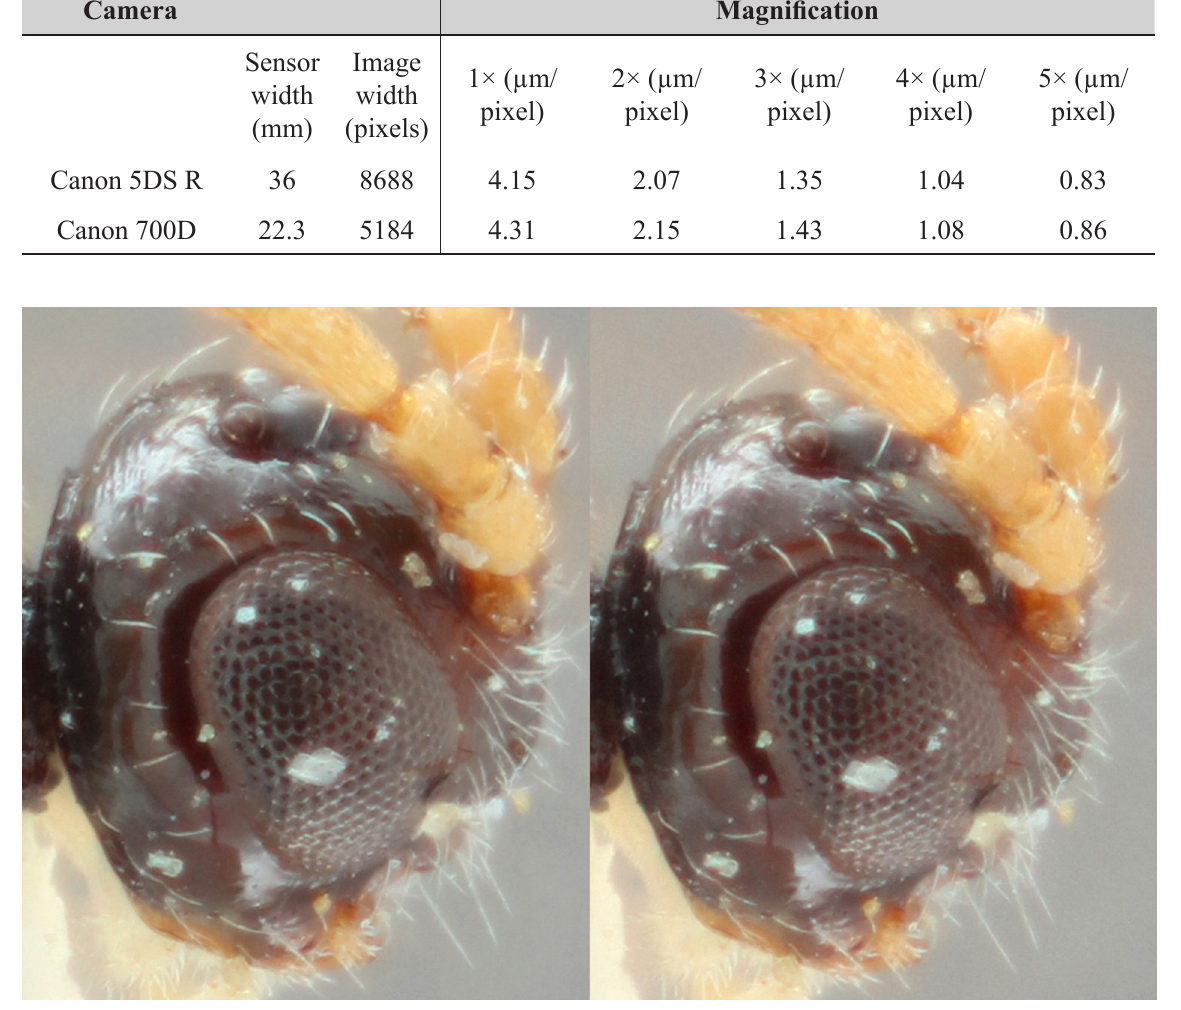
Fig. 2.2. Visual camera sensor comparison: A Hormius sp. specimen pictured at 4× magnification with a Canon EOS 5DS R (left) and a Canon EOS 700D (right).